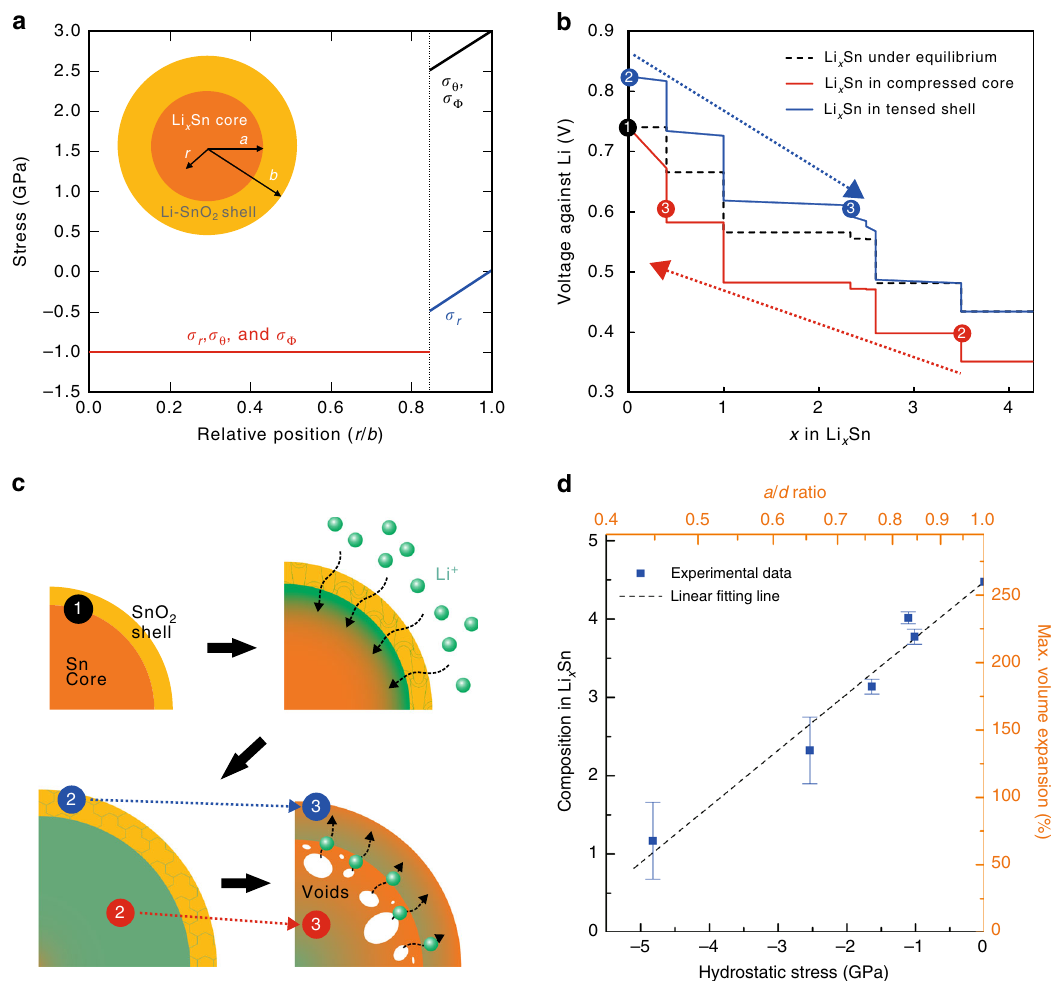
Fig. 4 Thermodynamic rationale for the strong stress – composition coupling. a The stress distribution within the particle during lithiation according to the relative radial position from the particle center, with the inset showing the lithiated particle geometry. The shell undergoes tensile plastic deformation while imposing compressive hydrostatic stress of 1 GPa on the core. b , c The stress effect on the equilibrium potential of the Li-Sn alloy system ( b ) and schematic illustrating the spontaneous core dealloying based on the stress-driven potential differences ( c ). The numbered circles illustrate the discrete timeframes during lithiation. d The experimentally observed stress – composition coupling in Li x Sn. The maximum volume expansion observed before dealloying initiation according to the core-to-particle radii ratio ( a / b ). The error bars indicate standard deviations in volume from 10 image frames separated by 1